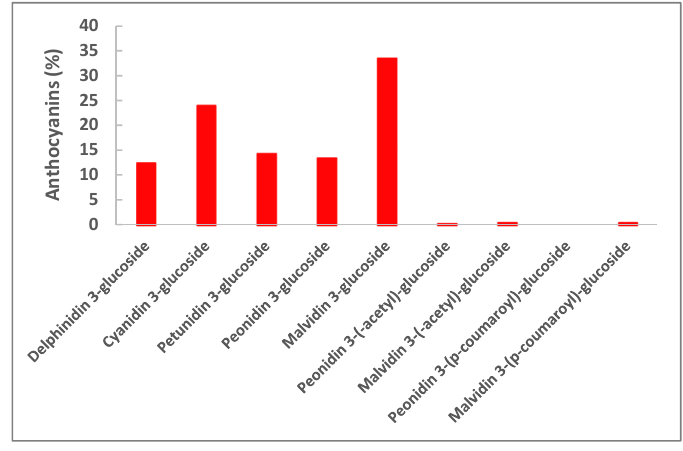
Figure 3. Composition (%) of anthocyanins in the juice at the end of processing.